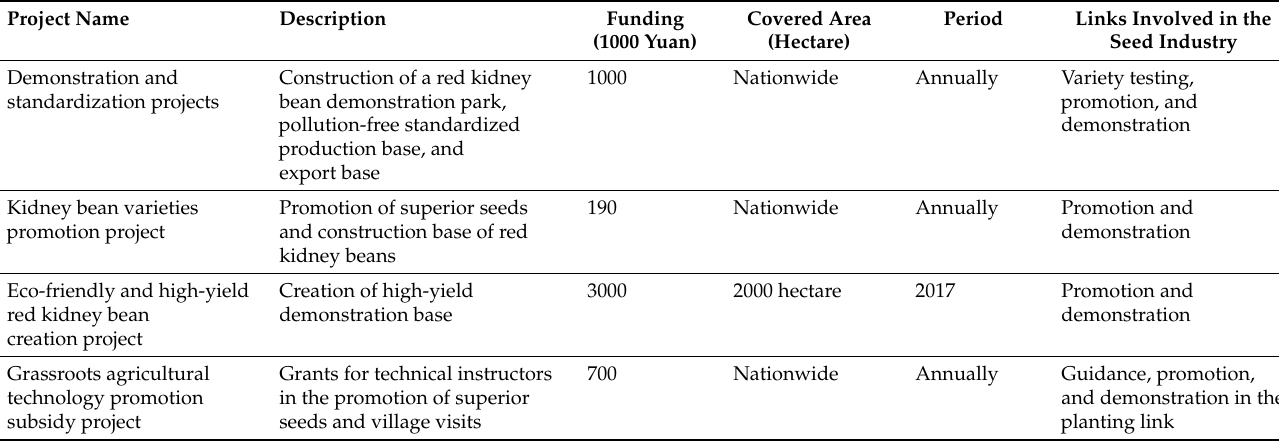
Table 4. List of funded projects in the study area.